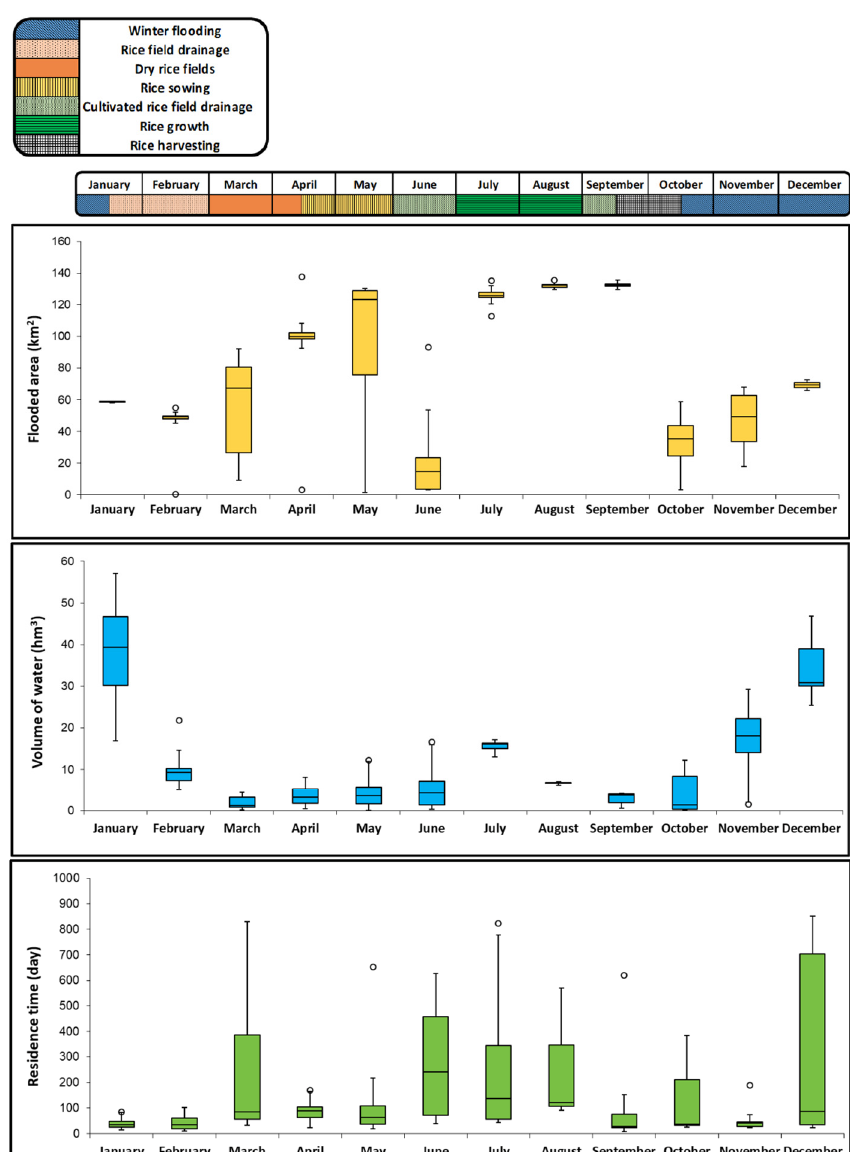
Figure 4. Seasonal changes in flooded area and water volume in rice fields (2006–2020) and residence times of the Albufera Lake (2006–2017) are showed in box-plots with median, percentiles and outlier values, together with the studied phases of the rice cultivation cycle developed in the Natural Park of Albufera.